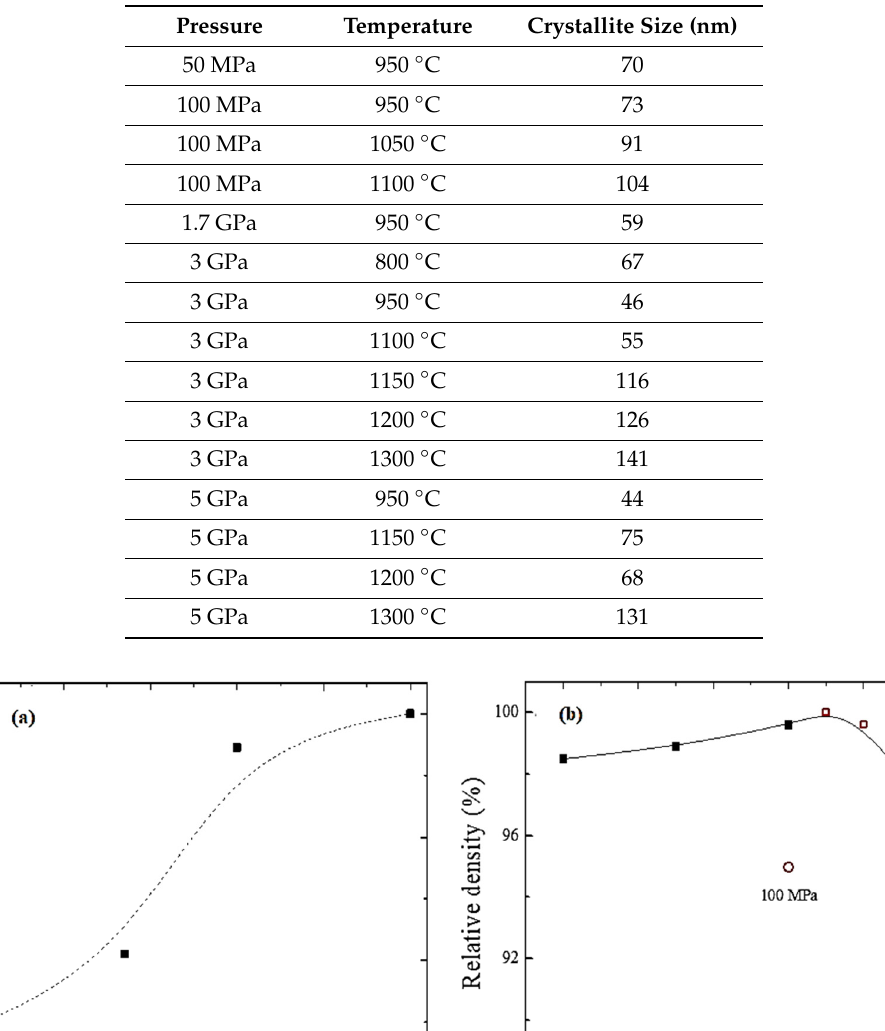
Table 1. Calculation of crystallite size by the Scherrer equation.